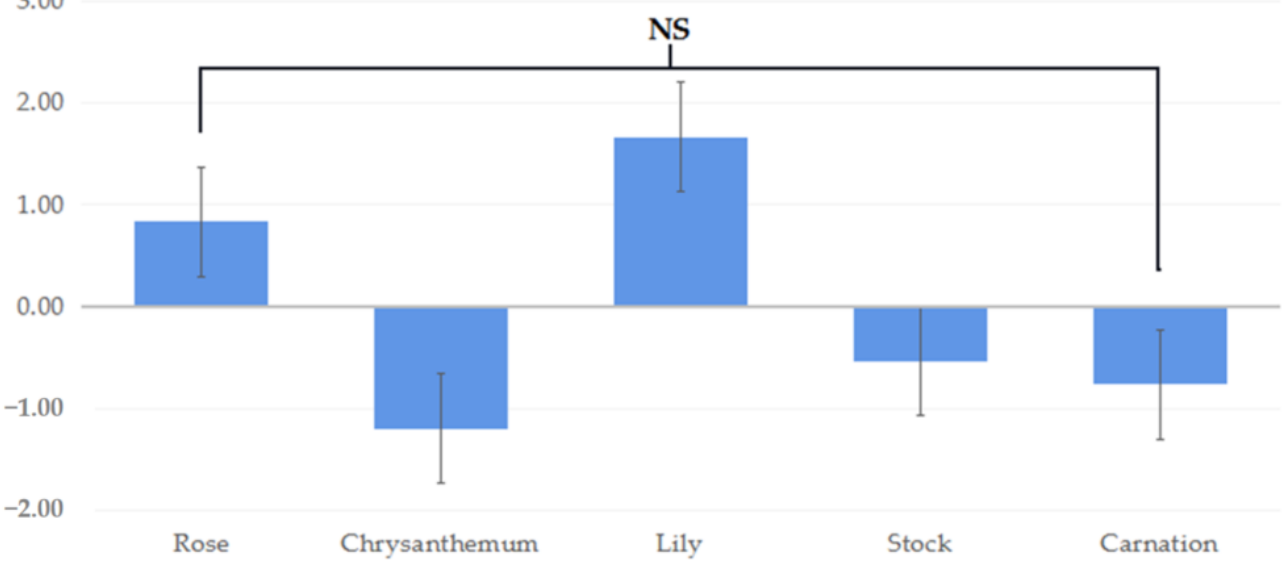
Figure 5. The result of total mood disturbance (TMD) is the total score on the profile of mood state (POMS) when performing five activities (NS = no significant difference).